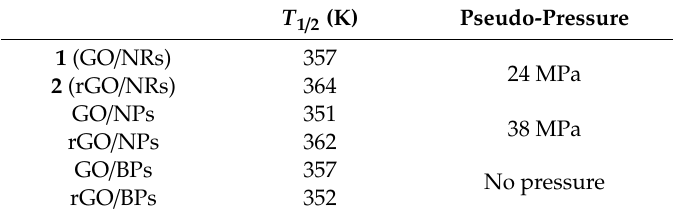
Table 1. Summary of spin crossover (SCO) temperatures ( T 1/2 ) and pseudo-pressure.